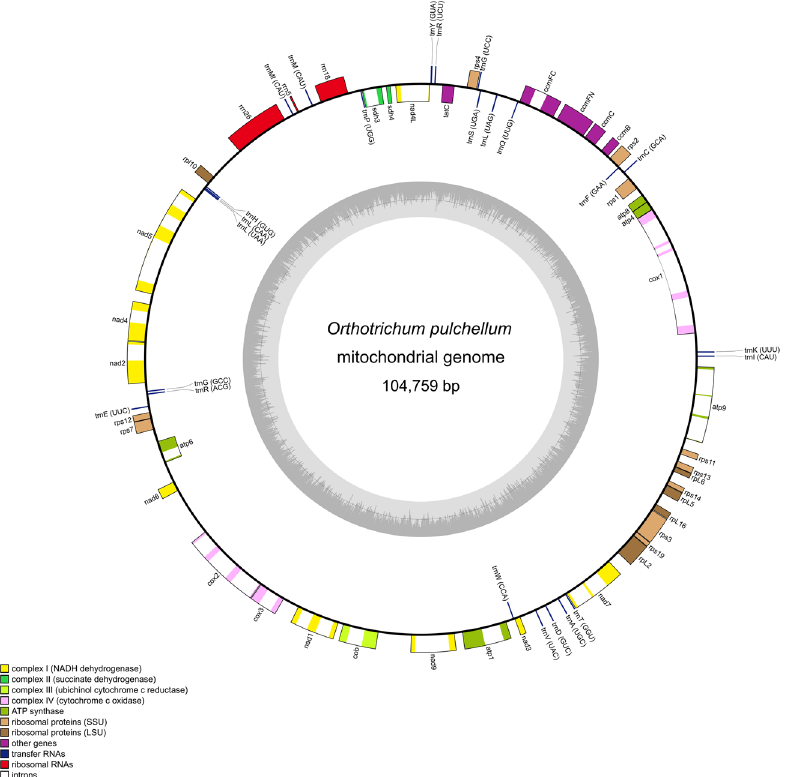
Figure 1. Gene map of the mitogenome of Orthotrichum pulchellum . Genes inside and outside the outer circle are transcribed in counterclockwise and clockwise directions, respectively. The genes are color coded based on their function. The inner circle visualizes the G/C content.